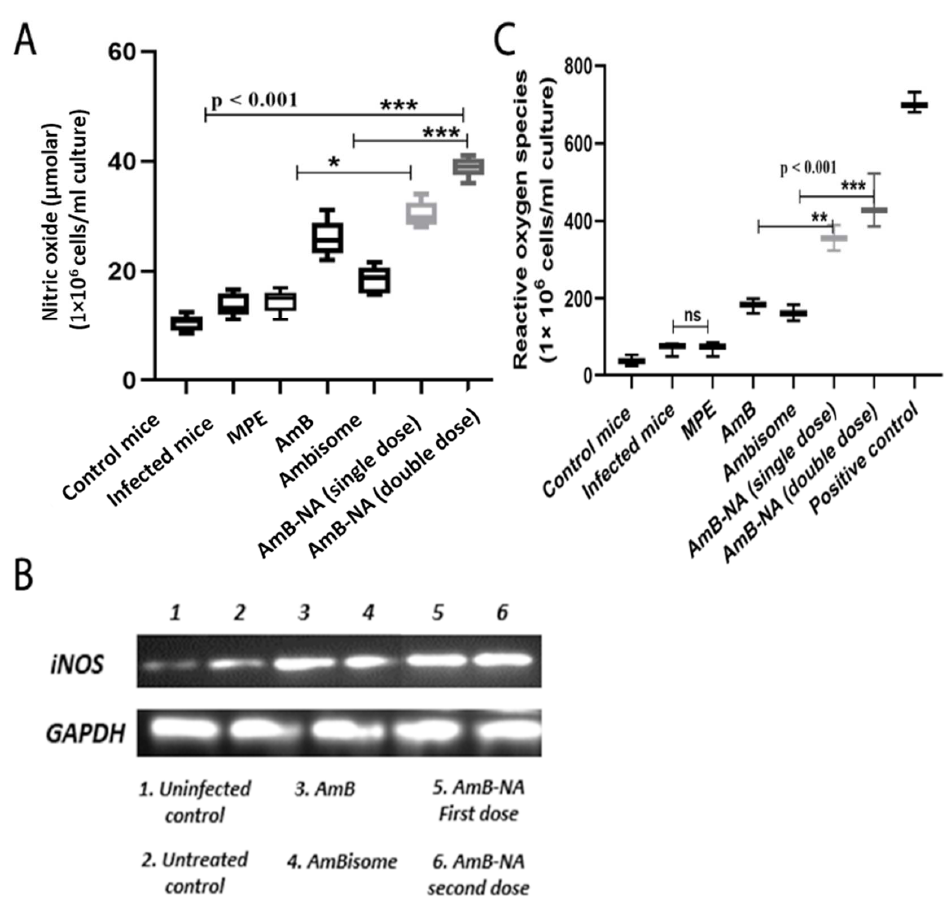
Figure 10. Assessment of NO generation. The figure denotes nitric oxide (NO) released from macrophages belonging to various groups of untreated and treated mice ( A ) Quantitative estimation of NO produced ( µ M) in the cultured supernatant of the splenocytes. The freshly isolated mononu- clear splenocytes cells were plated in a 12-well microtiter culture plate (1 × 10 6 cells/mL/well) and incubated in the CO 2 incubator at 37 ◦ C for 48 h. Data represented means ± SE for six mice per group and are representative of three independent experiments with similar results. * p < 0.05, ** p < 0.01, *** p < 0.001, ns = non-significant. ( B ) Semi-quantitative PCR for genes specific for iNOS, GAPDH was used as a control. ( C ) Measurement of reactive oxygen species (ROS). Data represented means ± SE for six mice per group and are representative of three independent experiments with similar results. * p < 0.05, ** p < 0.01, *** p <